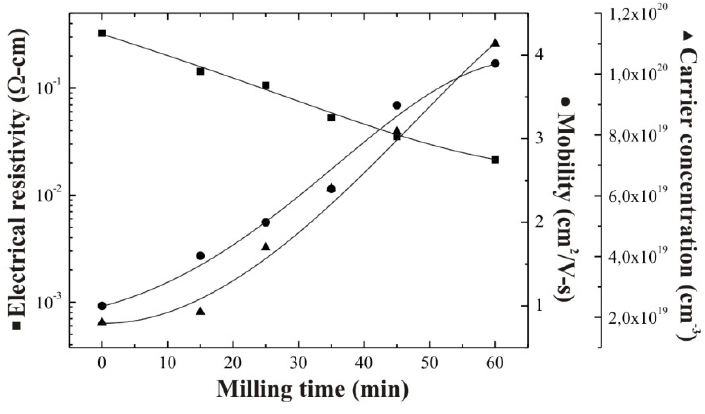
Figure 1. Electrical resistivity, electron mobility and carrier concentration as a function of the milling time of chemically sprayed ZnO:Al thin